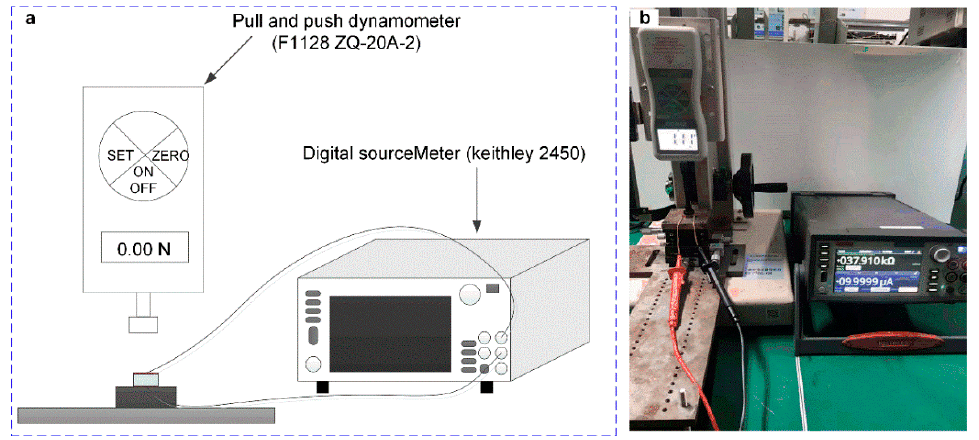
Figure 6. The testing platform. ( a ) The schematic diagram of the force-resistance testing platform. ( b ) The photo of the testing platform.